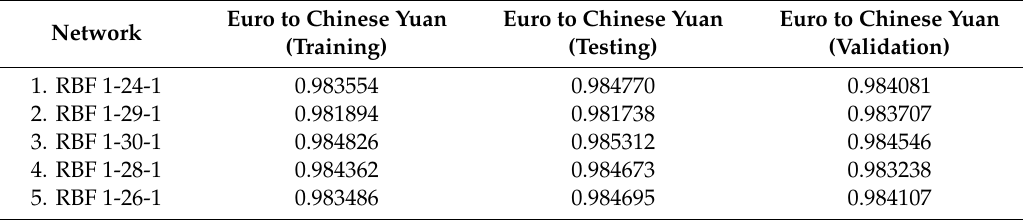
Table 3. Correlation coe ffi cients of individual data sets.